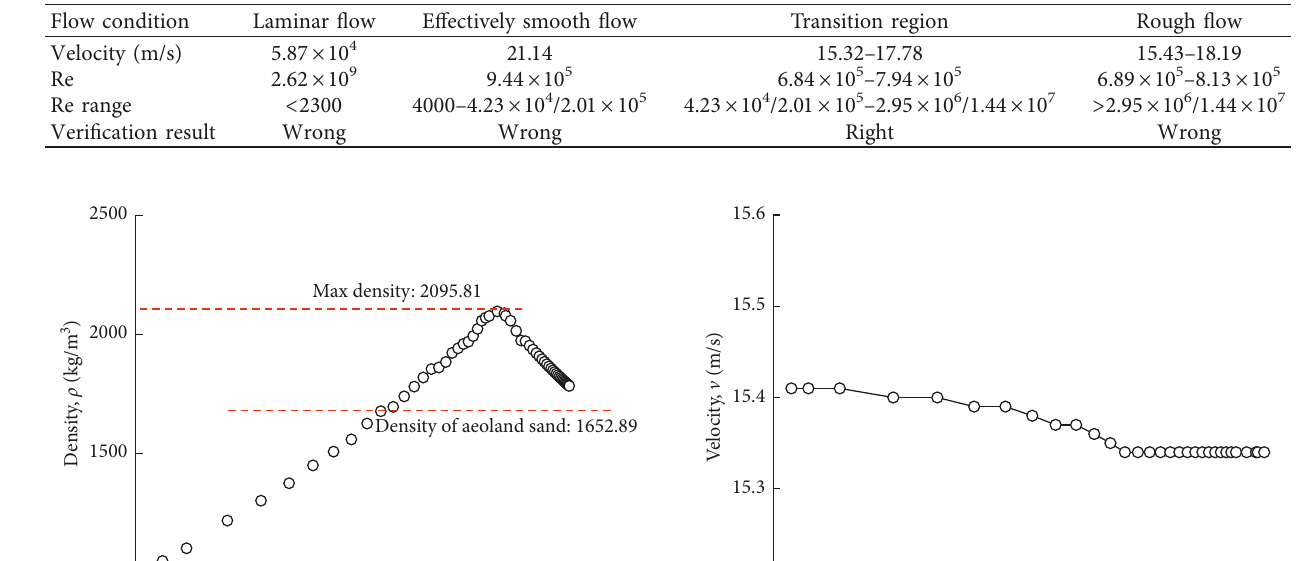
Table 7: Computing result.